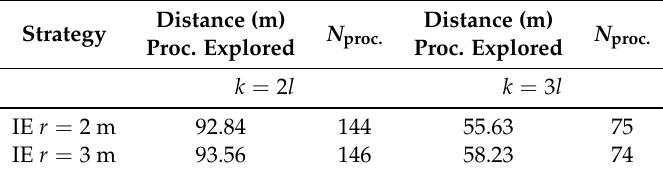
Table 8. Experiment E1—variation of sampling size: (i) mapping: Total travelled distance needed to explore the map with accompanied number of obtained process measurements up to that point N proc.,map and process NMSE; (ii) process exploration: Total exploration distance to explore the process and number of collected measurements ( N proc. ) required to achieve NMSE of 0.34 with respect to ground